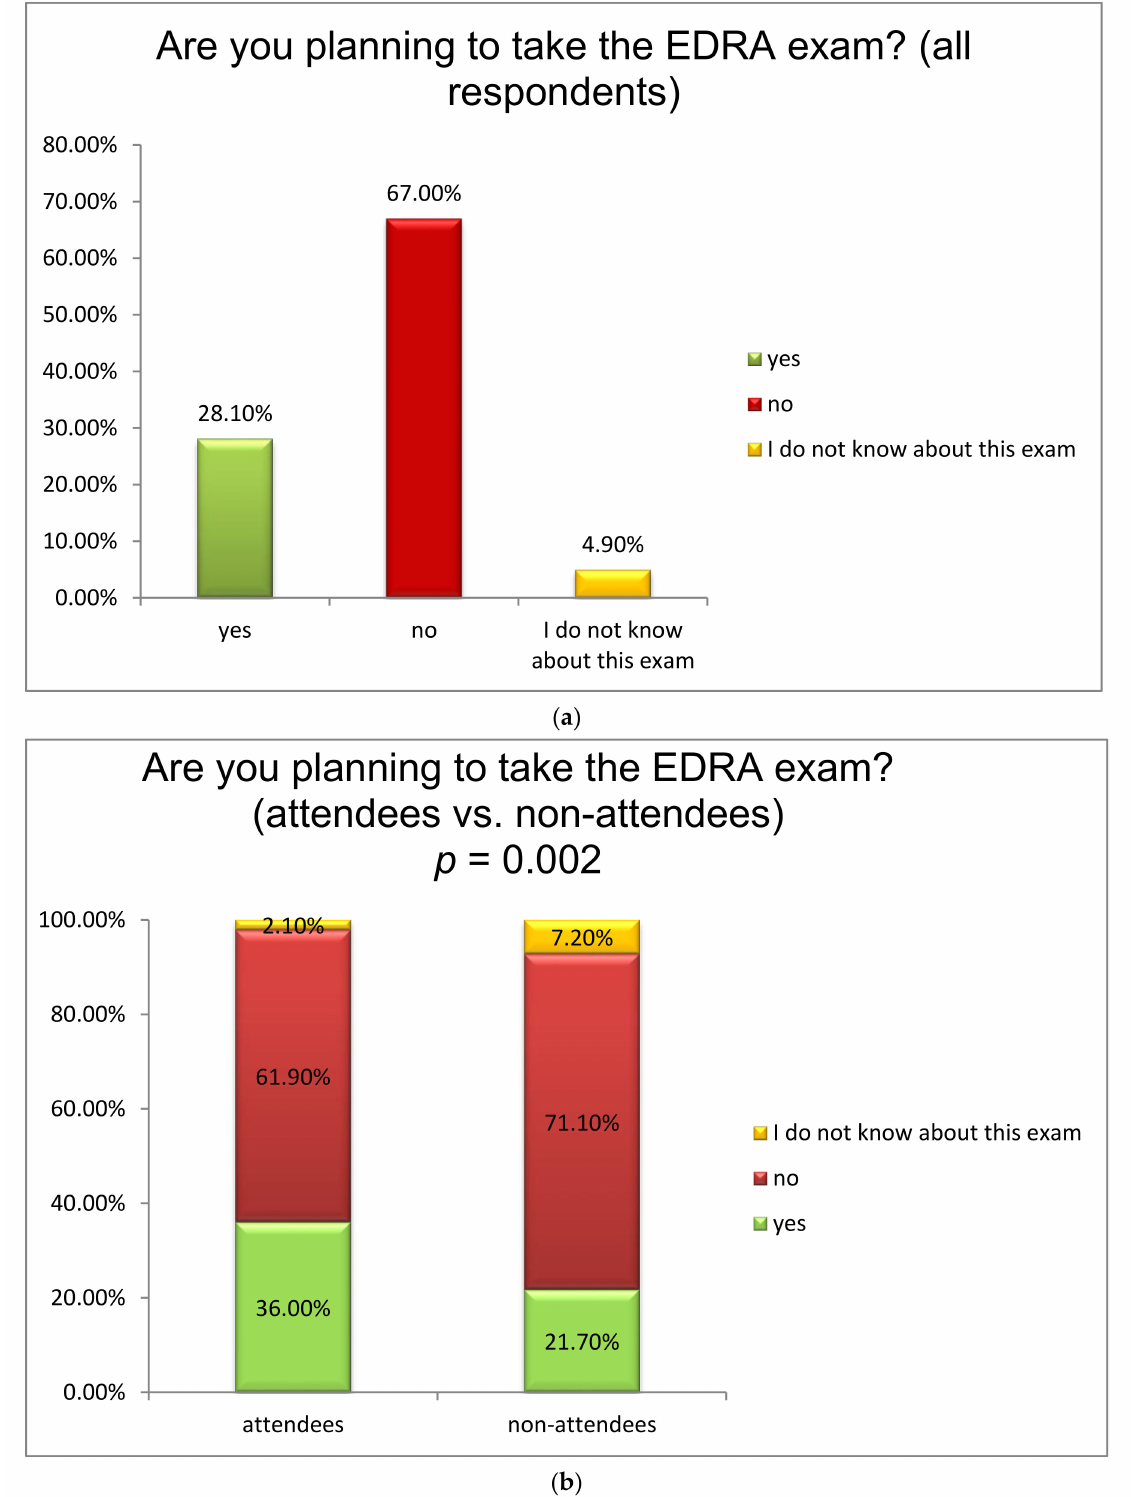
Figure 4. ( a ) Willingness to take the European Diploma of Regional Anesthesia (EDRA) exam (all anesthesiologists who responded to the survey); ( b ) Willingness to take the European Diploma of Regional Anesthesia (EDRA) exam (attendants versus non-attendants of the regional anesthesia